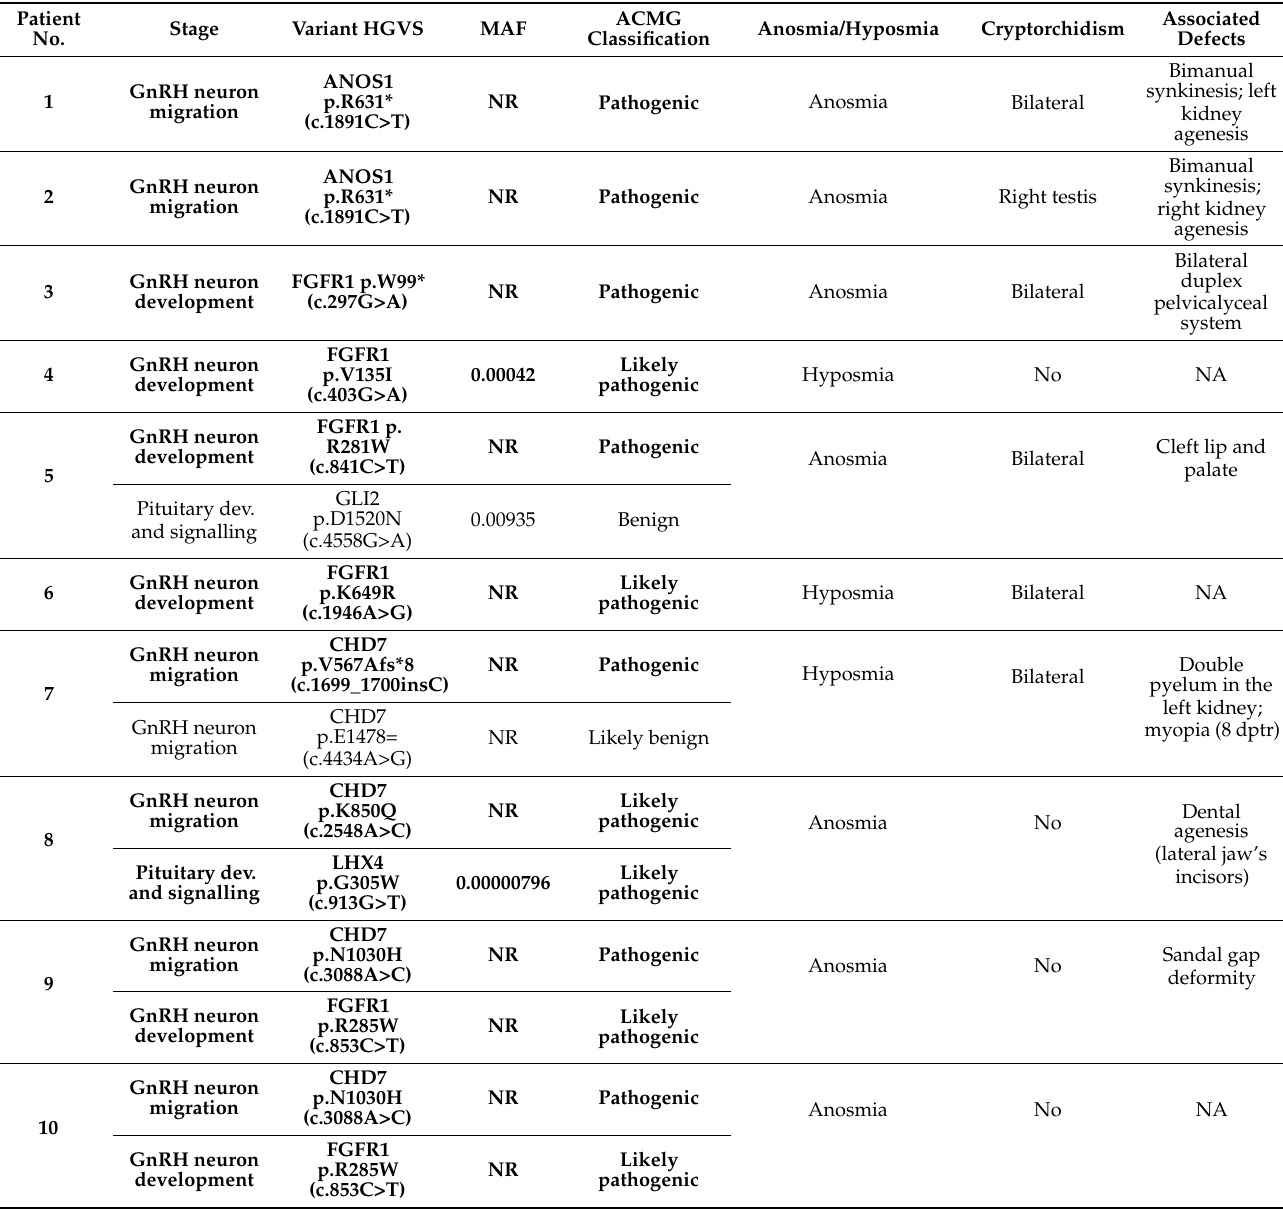
Table 1. KS patients with genetic defects in primary GnRH neuron development/migration. Patient